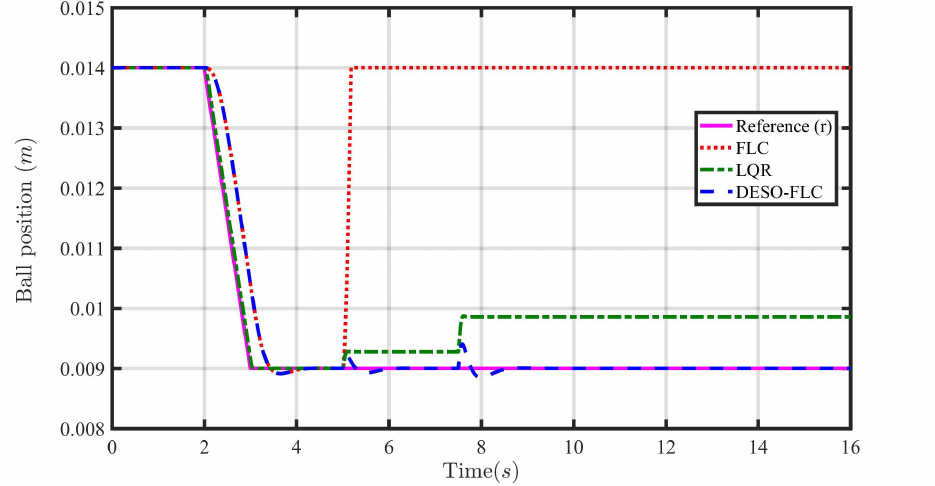
Figure 8. Response of the steel ball position ( x 1 ) in the presence of parametric uncertainties.